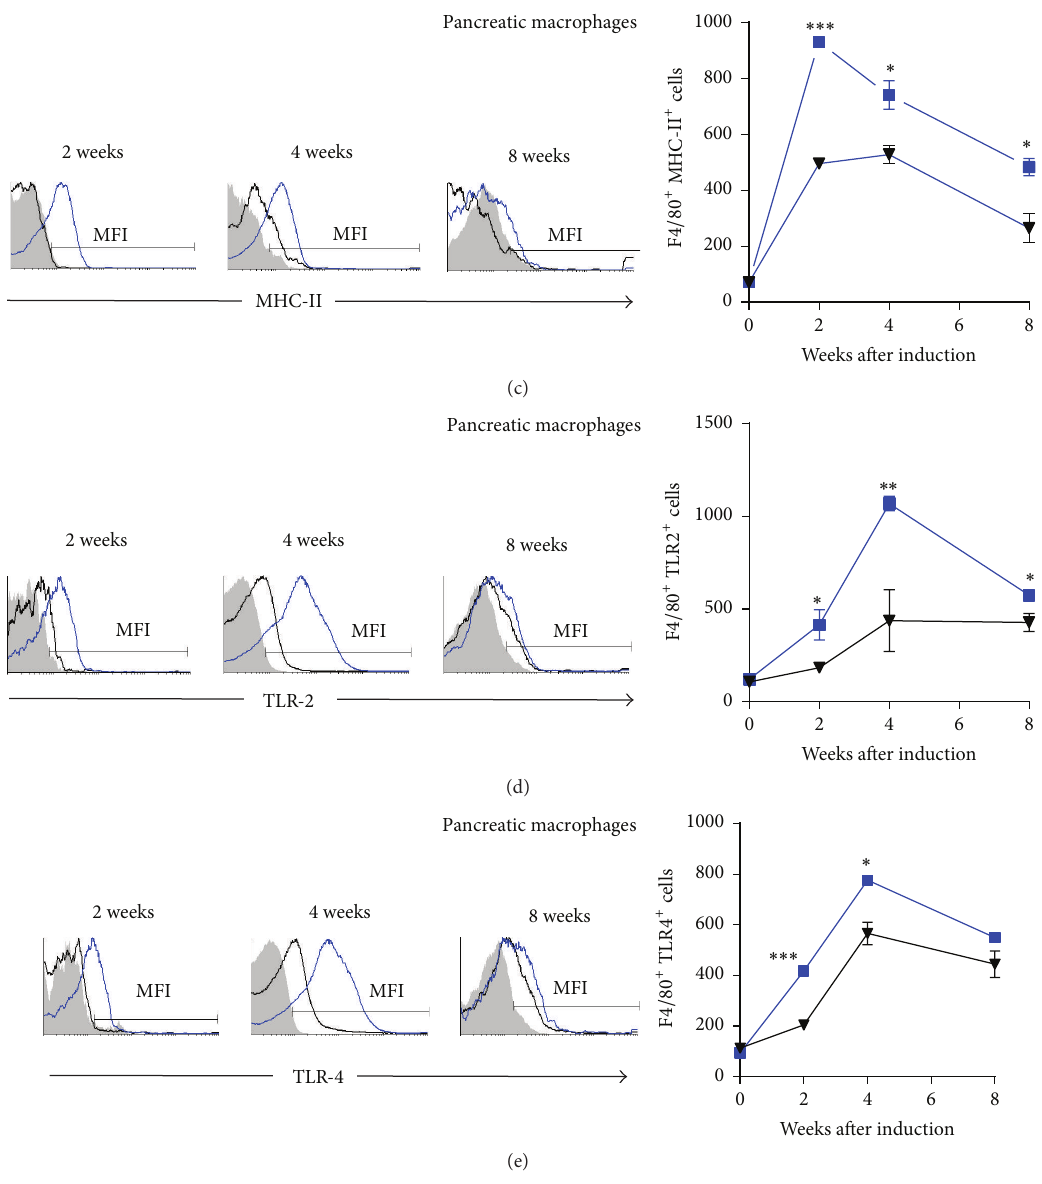
Figure 7: Mif promotes costimulatory molecule expression on pancreatic M 𝜑 . The time course of costimulatory molecule: CD80 (a), CD86 (b), MHC-II (c), TLR-2 (d), and TLR-4 (e) expression on pancreatic F4/80 + M 𝜑 . M 𝜑 from pancreas of Wt and Mif − / − mice were harvested at 0,2,4,and8weeksafterSTZadministrationand1 × 10 7 cells/mLwereprocessedbyflowcytometricanalysisasindicatedinSection 2.Analyses of expression are shown in the right panels: WtSTZ ( ◼ ); Mif − / − STZ ( 󳶃 ). And representative histograms of expression based on fluorescence are shown in the left panels. Isotype controls are indicated in gray shadow, the black line represents expression by Mif − / − STZ cells, and the blue line shows expression by WtSTZ cells. The data are presented as the mean fluorescence intensities (MFI) from one representative experiment. Each experiment was repeated three times ( 𝑛 = 3 ) and individually analyzed. ∗ 𝑝 < 0.05 , ∗∗ 𝑝 < 0.01 , or ∗∗∗ 𝑝 < 0.001 , GraphPad Prism software